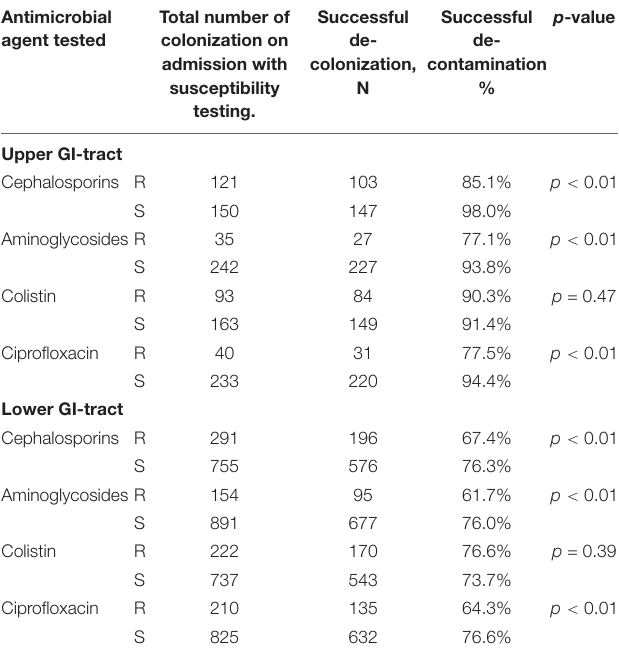
TABLE 5 | Decontamination rates when decontamination is defined as two consecutive negative cultures. Antimicrobial agent